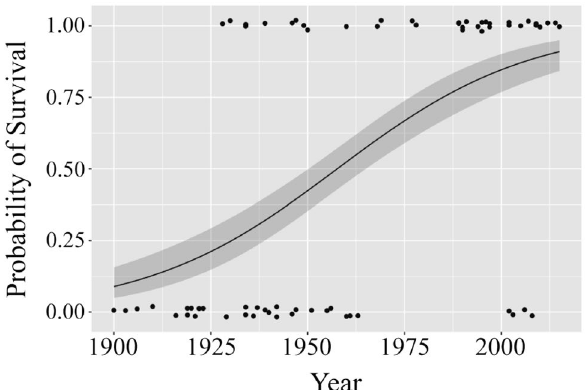
Figure 3. Probability of surviving a bull shark bite over time. Time was not a significant predictor for survivability of tiger and white bites. Figure created using R v. 3.5.0 (www.r- proje ct.